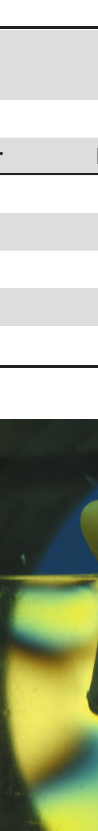
Table 1- Principal stresses (MPa) in the selected points of interest